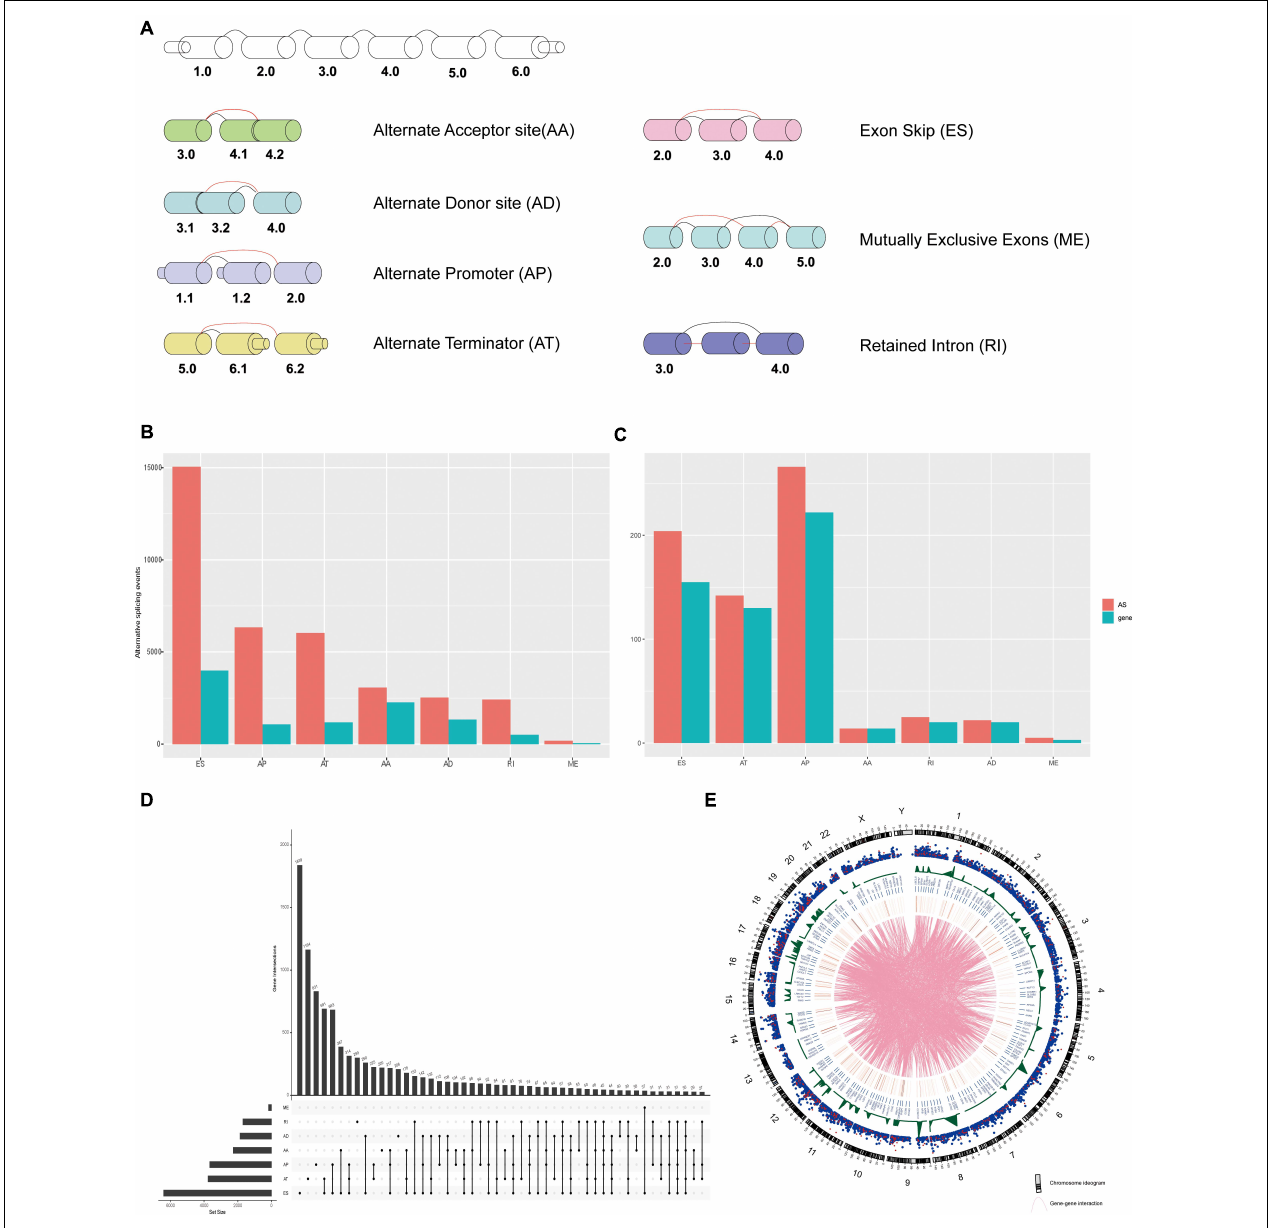
FIGURE 2 | (A) The schematic diagram of the seven AS event patterns. (B) The number of AS events and their parental genes in BrCa patients. (C) The number of DEAS events and their parental genes in BrCa patients. (D) The upset diagram shows the intersection of the seven types of splicing events in BrCa. (E) Circos of AS events on chromosomes and their parent gene annotations. The outer circle consists of a point map representing the detected AS events, which is linked to the position of the parent gene in the chromosome, and the red dots represent the DEAS events. The blue dots represent 454 the non-differentially expressed AS events. The gene in the middle is called the DEAS event parent. 455 Lines represent potential interactions between parental genes of the DEAS